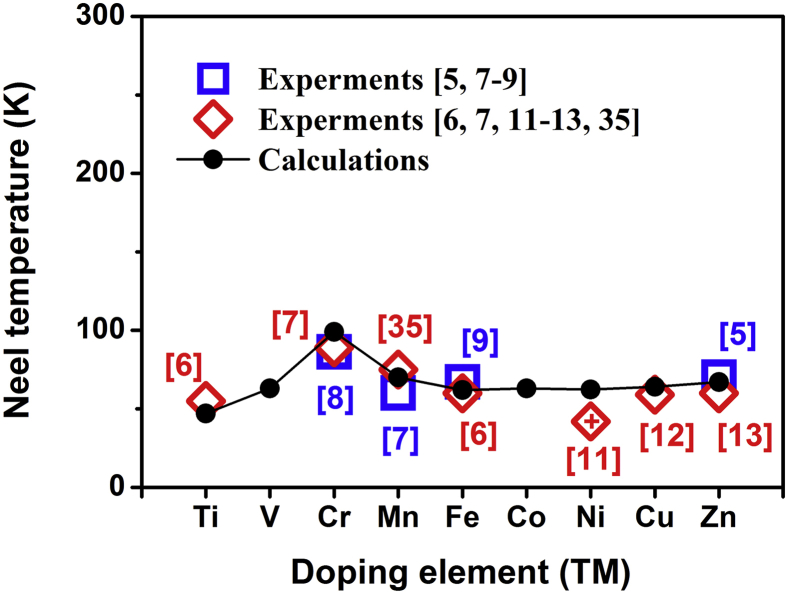
Variation of Néel temperatures with the TM dopant in YMn0.917TM0.083O3 (TM = Ti∼Zn) bulks in comparison with the experimental data. In the figure, the symbol Image 1 denotes the reference value from the experimental phase of YMn0.8Ni0.2O3[11].